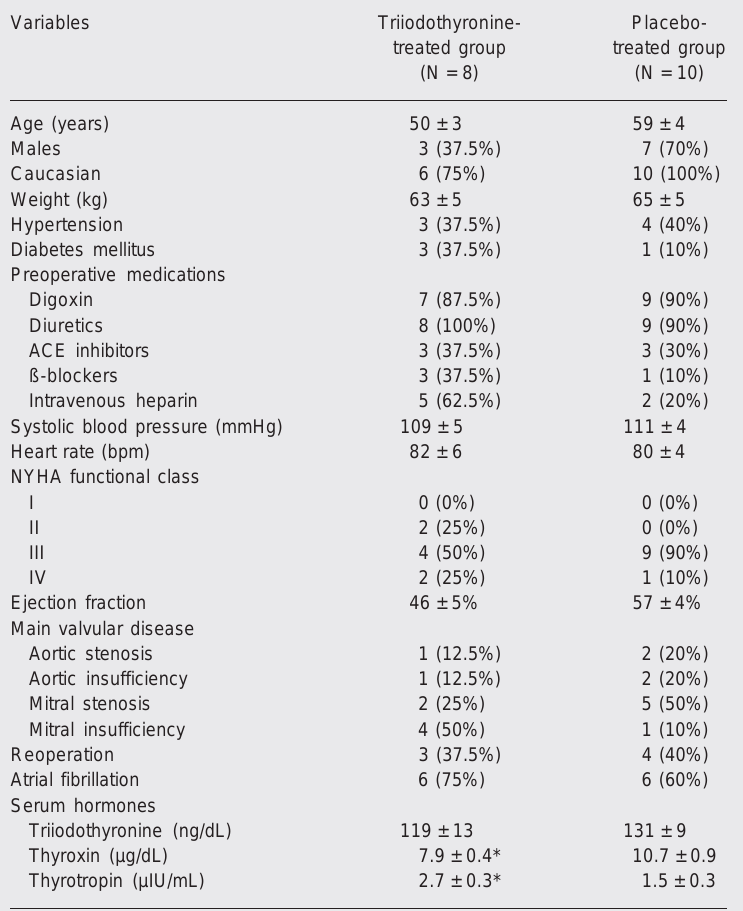
Table 1. Preoperative baseline characteristics of patients treated with triiodothyronine and